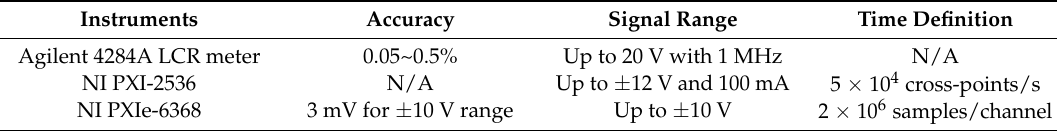
Table 4. Specifications of measurement instruments used for